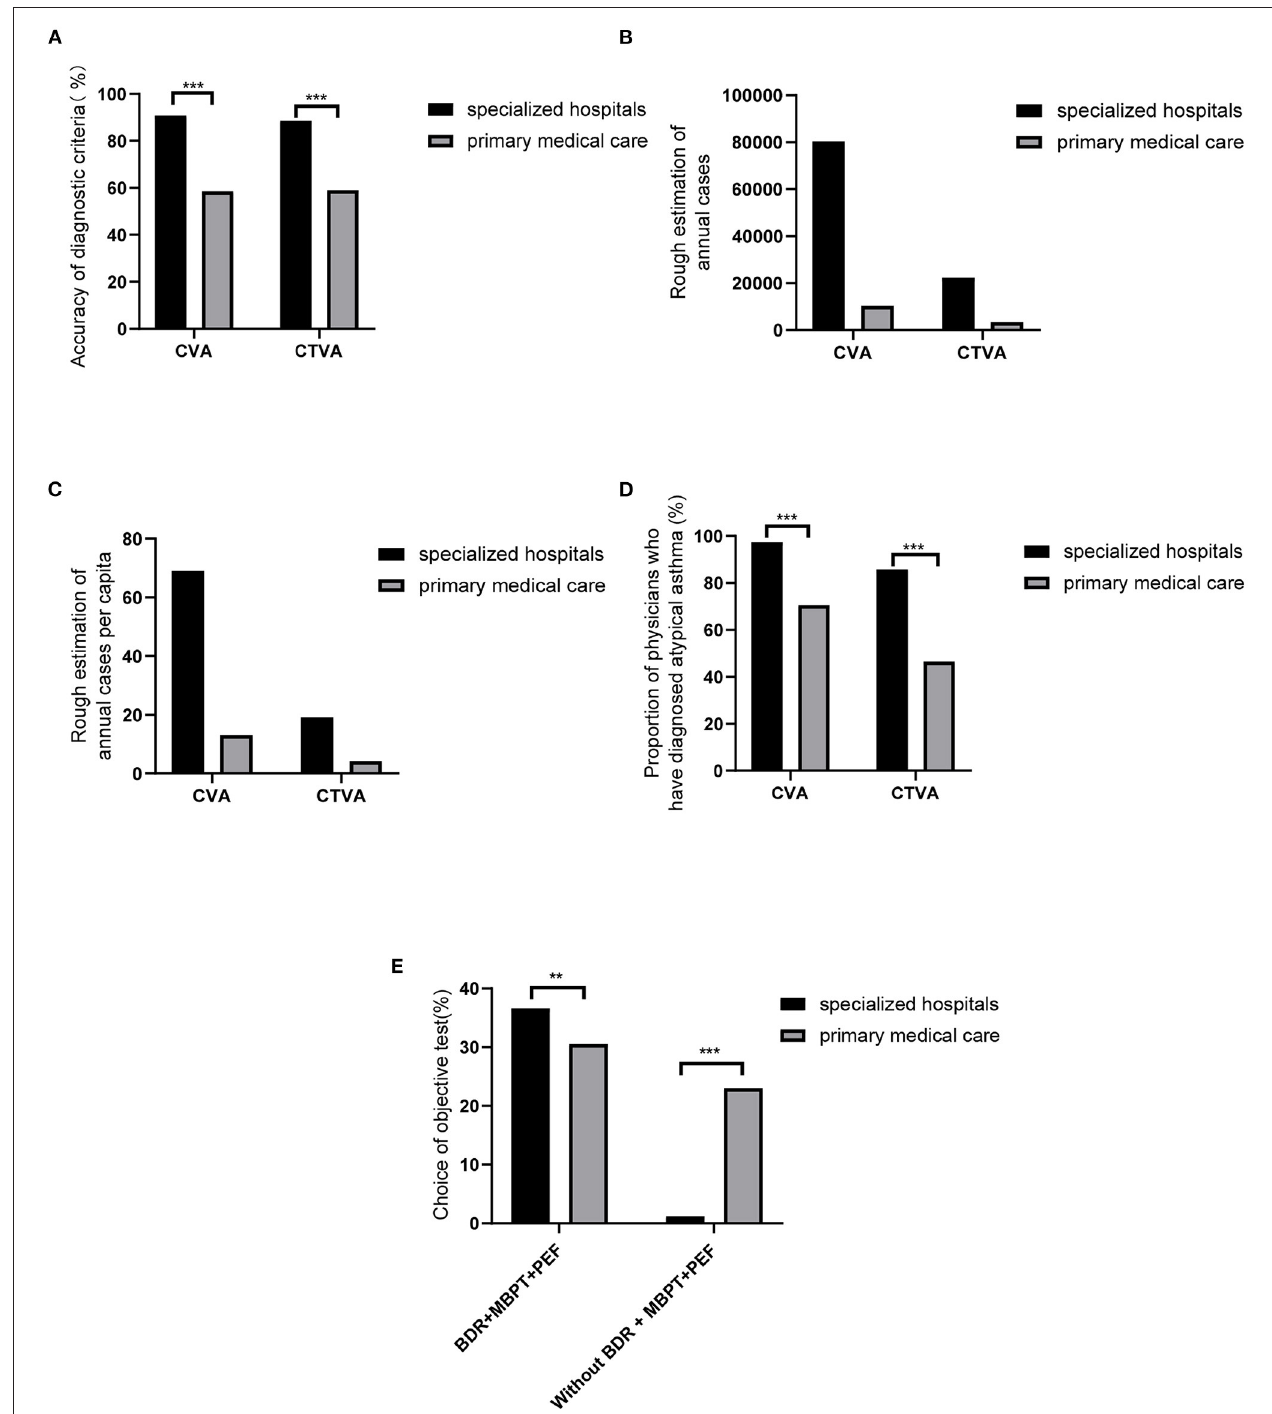
FIGURE 2 | Diagnosis of CVA and CTVA. Accuracy of diagnostic criteria (A) , Rough estimation of annual cases (B) , Rough estimation of annual cases per capita (C) , Proportion of physicians who have diagnosed atypical asthma (D) , and Choice of objective test (E) in specialized hospitals and primary medical care facilities. BDR, bronchodilation tests; MBPT, methacholine challenge; PEF, peak expiratory flow. ** P < 0.01, *** P < 0.001.